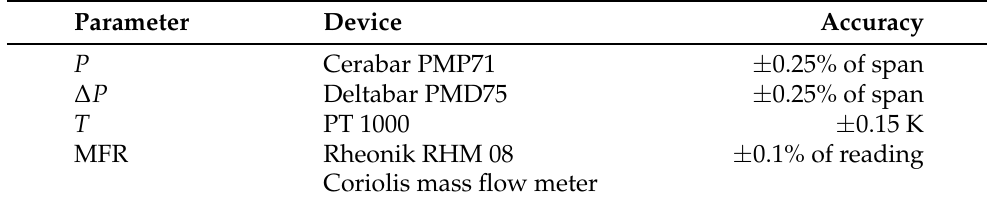
Table 2. Characteristics of the measuring devices.